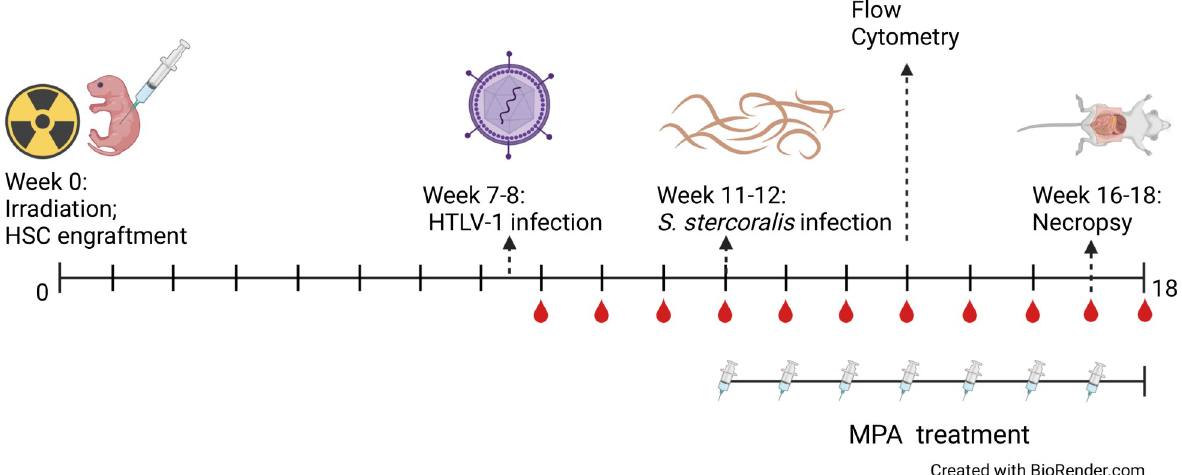
Fig 1. 24–48-hour old NSG pups were irradiated with 1.5 Gy. Five hours post irradiation, mice were intra-hepatically injected with 10 5 human hematopoietic stem cells (HSC) isolated from cord blood. Humanized mice were assigned to four groups: HTLV-1 infected, HTLV-1/ S . stercoralis coinfected, S . stercoralis infected, and S . stercoralis infected with methylprednisolone acetate (MPA) treatment. At 7–8 weeks post HSC engraftment, coinfected and HTLV-1 infected groups received an intraperitoneal injection of 2 x 10 6 irradiated MT-2 cells carrying HTLV-1. The coinfection, S . stercoralis infection, and MPA treated groups were inoculated with 5,000 L3i at 11–12 weeks post HSC engraftment. Steroid treated mice received 2 mg of MPA intraperitoneally weekly from the time of S . stercoralis infection until the end of the experiment. Coinfected and HTLV-1 infected groups were bled weekly post MT-2 injections and blood was analyzed for viral DNA and RNA analysis. Blood was collected from coinfected, HTLV-1 infected, and S . stercoralis infected groups once at 13–14 weeks post HSC engraftment for flow cytometry analysis. Necropsies were performed at 16–18 weeks post HSC engraftment. The figure was generated using